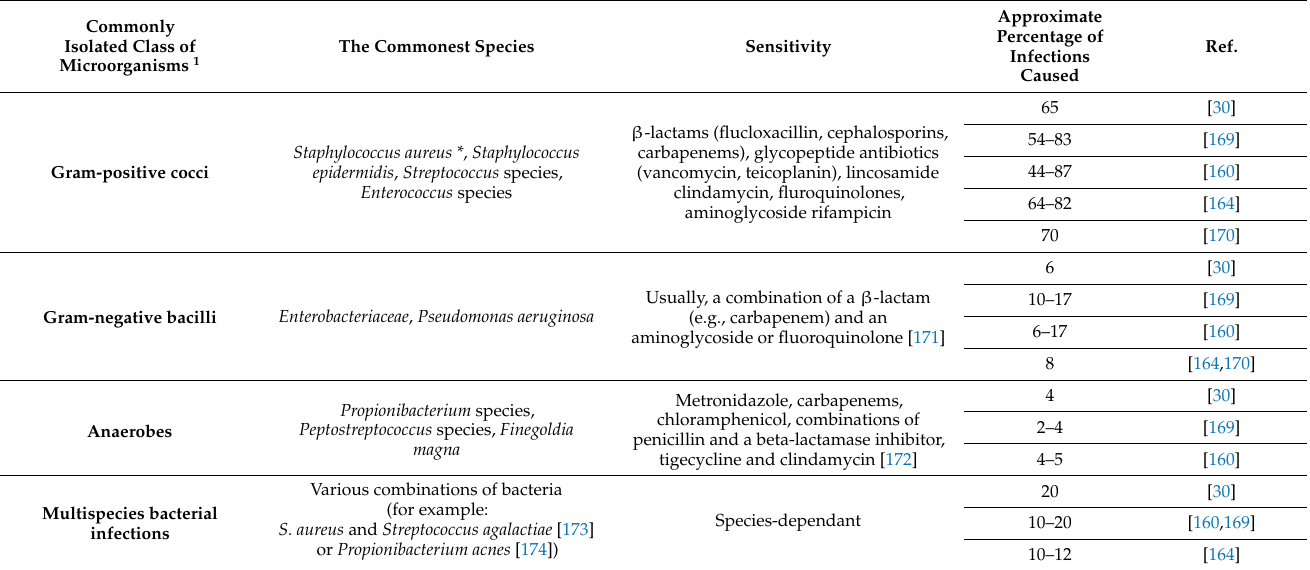
Table 5. A list of microorganisms known to be causing implant-associated infections (IAI) in ortho- pedic practice and examples of antibiotics that efficiently control against the corresponding class of